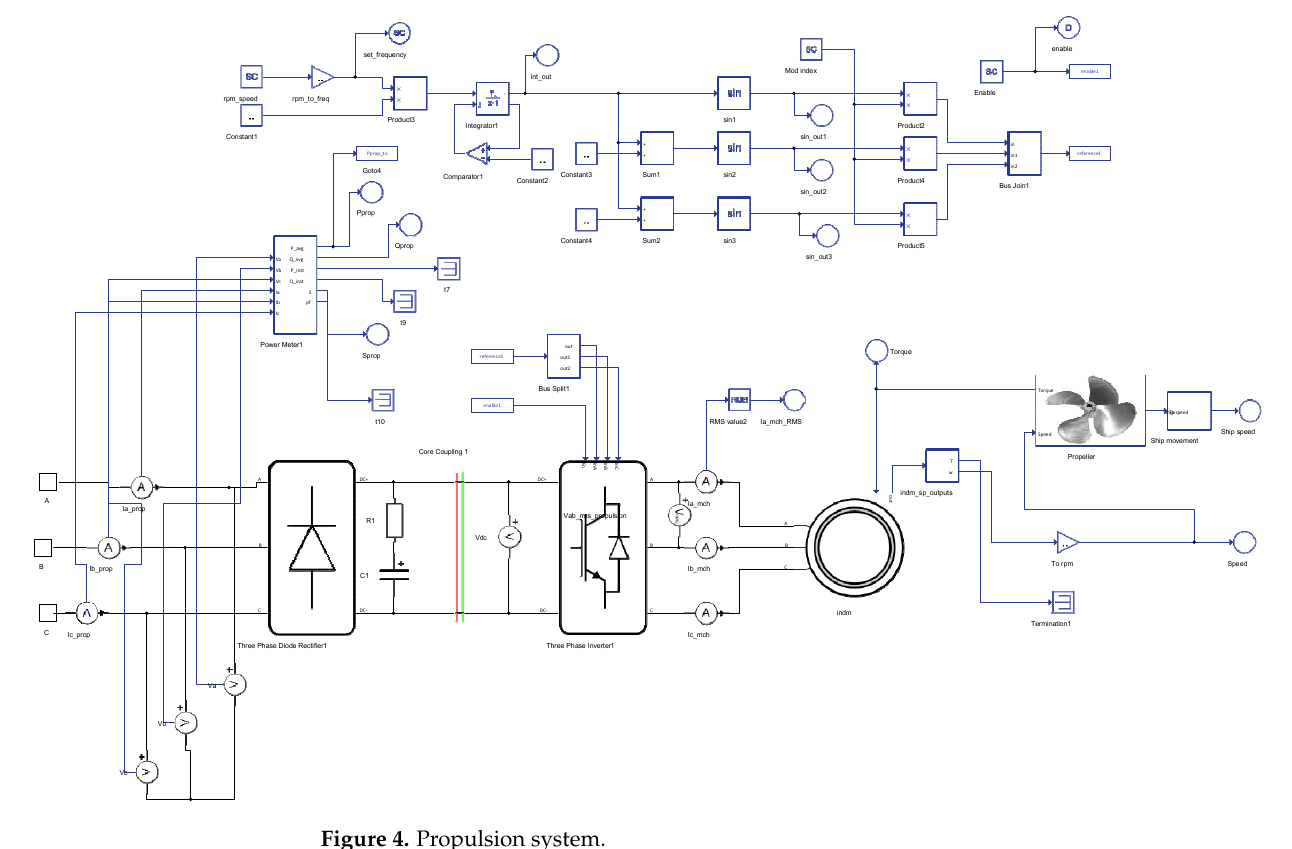
Figure 4. Propulsion system.